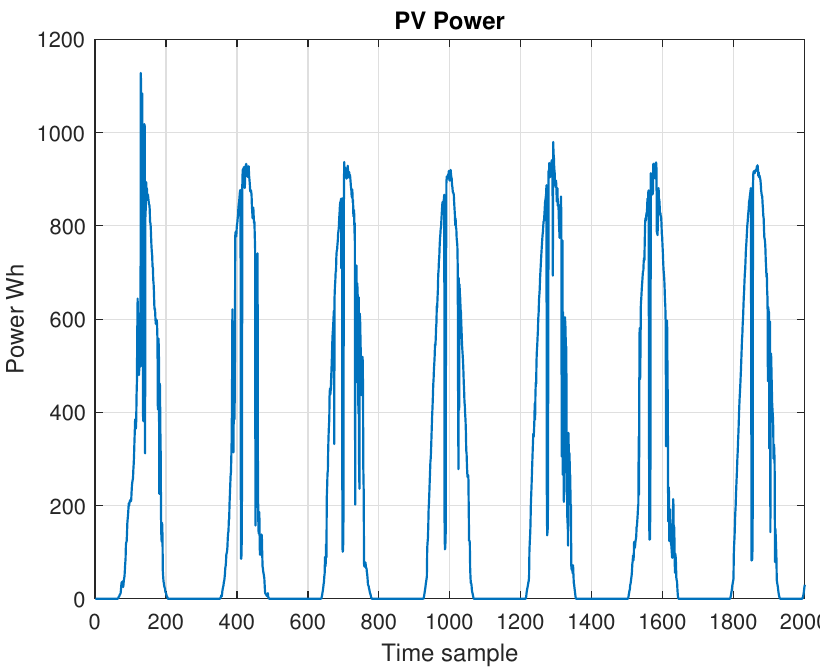
Figure 7. PV power output for the period between January 8 and January 15 2020. The meteorological station database registered the minute-to-minute information of relative humidity, solar radiation, temperature and wind speed for the same observation period. The complete system database involves 50,198 samples in 5 min intervals with information of one output variable (PV power) and four input variables (relative humidity, solar radiation, temperature and wind speed). A correlation analysis using the Pearson coefficient ( r ) [39] was performed to corroborate the influence of input variables on the output, and the results are shown in Table